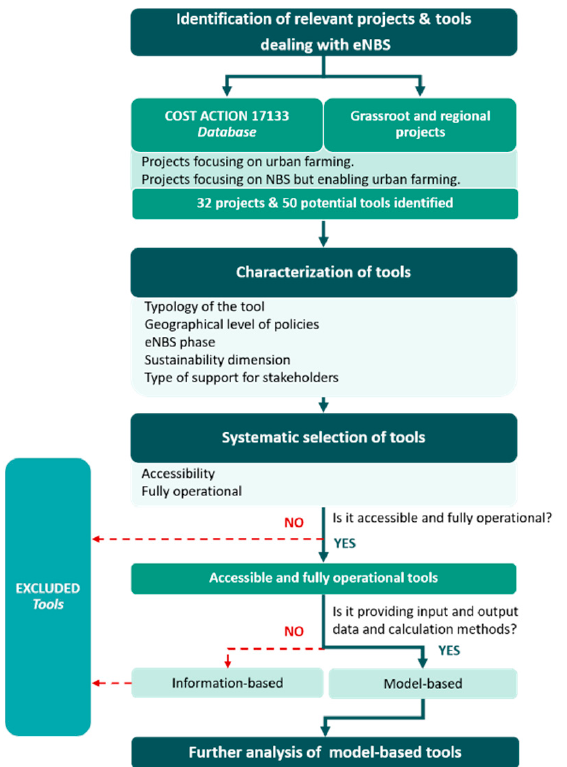
Figure 1. Graphical representation of the method applied to select, characterise and analyse the tools.